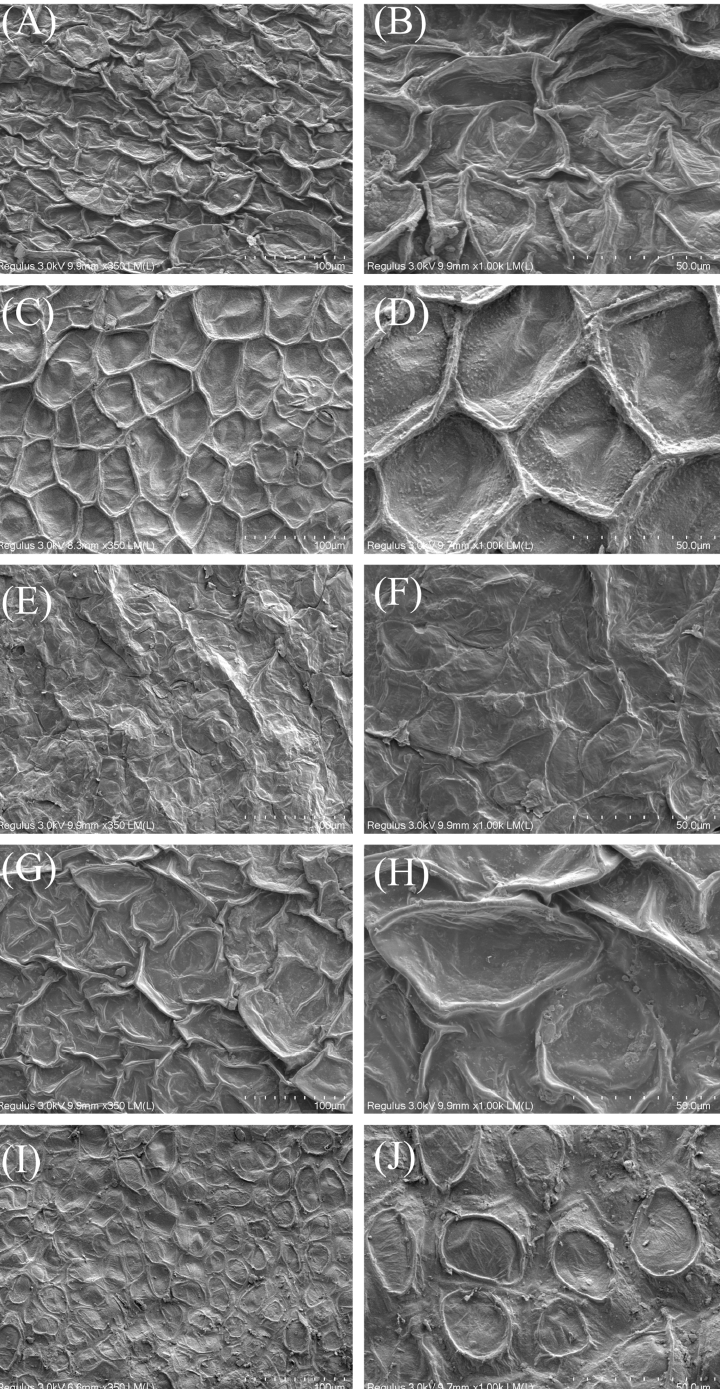
Figure 3. Scanning electron micrographs of ( A ) FIRD, 350 × , ( B ) FIRD, 1000 × , ( C ) VD, 350 × , ( D ) VD, 1000 × , ( E ), MVD, 350 × , ( F ), MVD, 1000 × , ( G ) HD, 350 × , ( H ) HD 1000 × , ( I ) FD, 350 × , and ( J ) FD, 1000 × at two different scales (100 µ m and 50 µ